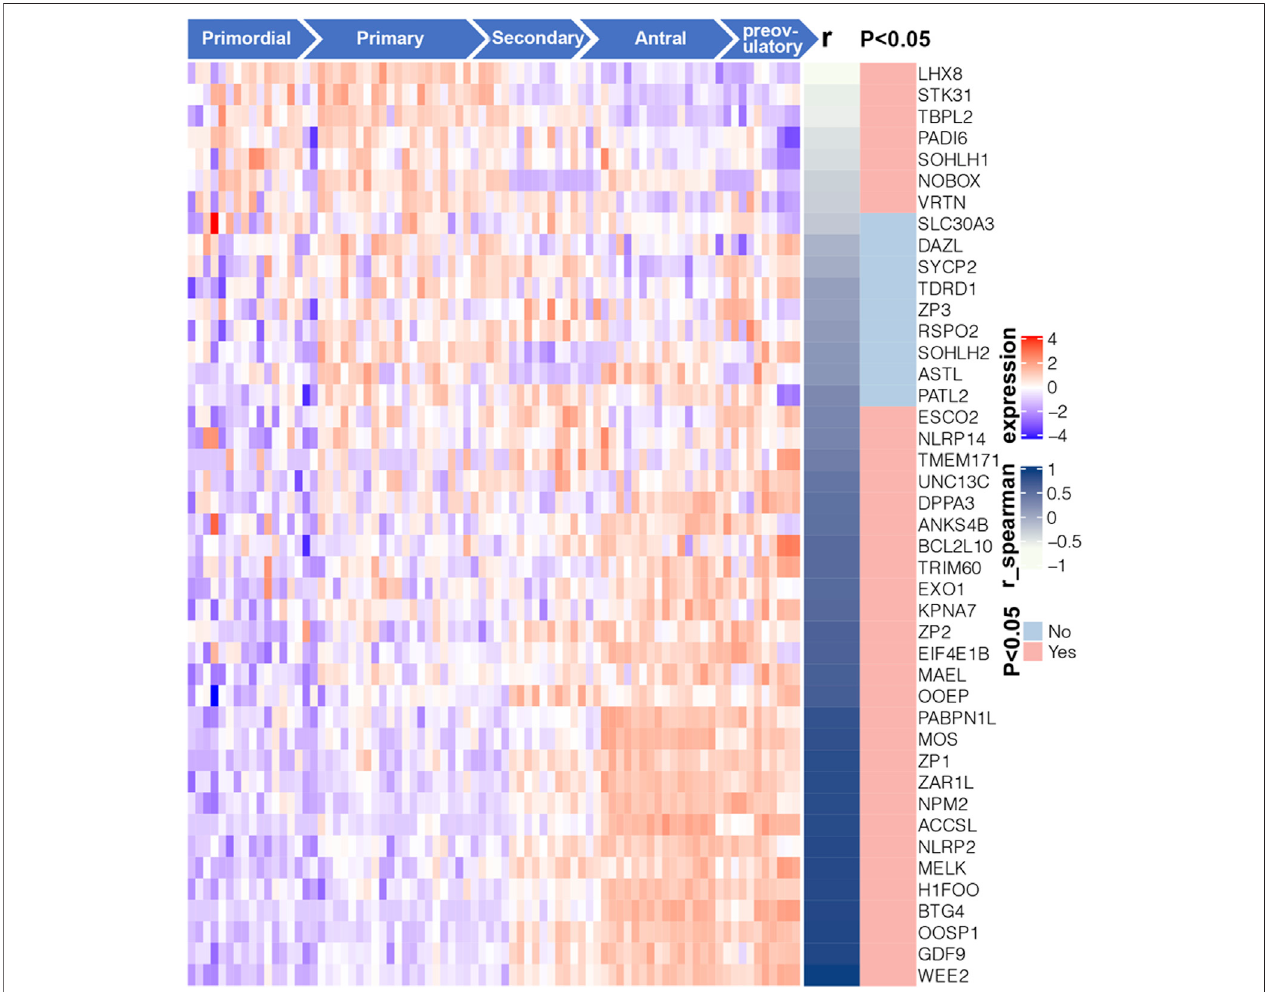
FIGURE 4 | Expression pro fi le and correlation with follicular developmental of 43 candidate Oo-speci fi c genes. Heatmap displays the expression levels of 43 candidate Oo-speci fi c genes in the oocytes at fi ve stages of folliculogenesis in the GSE107746 dataset. The right panel of the heatmap shows the correlation between the expression levels of each gene with the follicular developmental stages in the GSE107746 dataset.